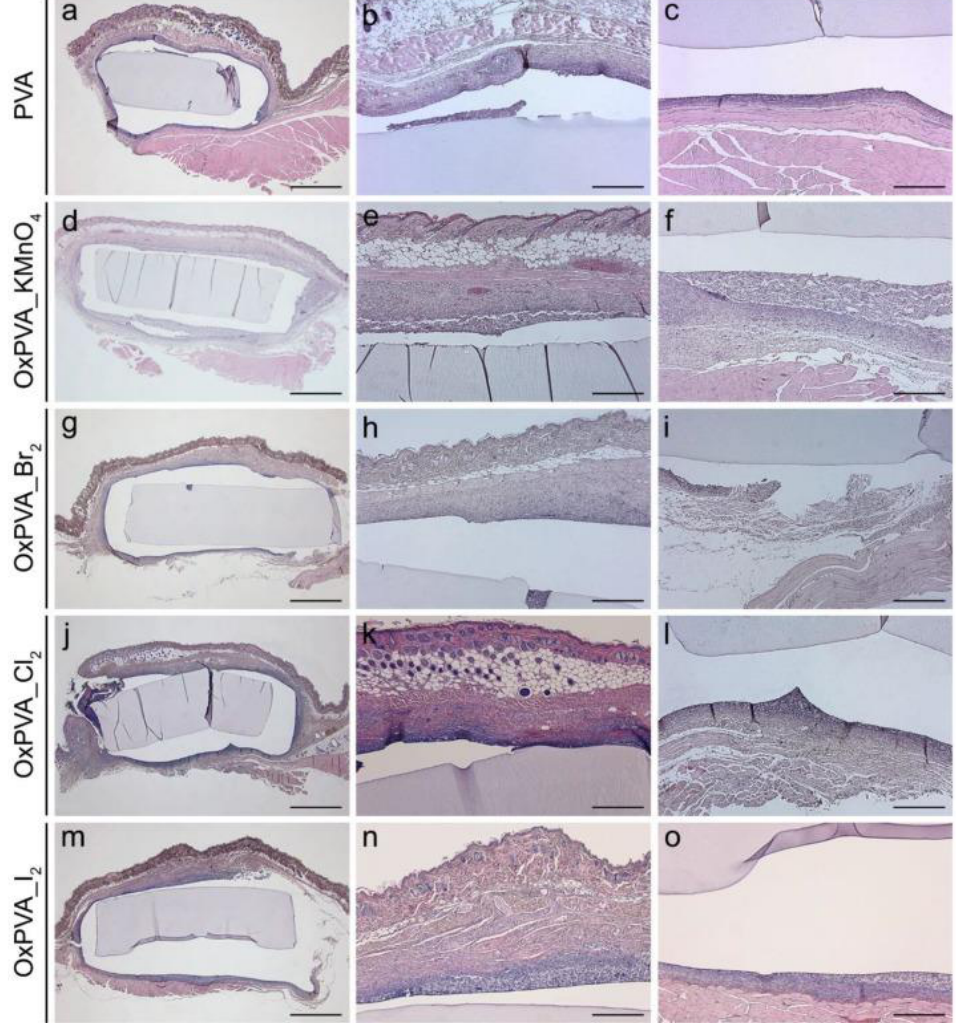
Figure 1. Histological evaluation of oxidized PVA scaffolds. Hematoxylin and eosin staining of neat and oxidized PVA scaffolds after four weeks of subcutaneous implantation into the dorsal region of BALB/c mice. ( a , d , g , j , m ) All hydrogel disks could be well identified among the surrounding tissues. ( b , e , h , k , n ) No severe inflammatory infiltration was observed at the subcutaneous and ( c , f , i , l , o ) muscular sides. Scale bars: ( a , d , g , j , m ) 100 µm; ( b , c , e , f , h , i , k , l , n , o ) 400 µm. OxPVA_KMnO 4 : PVA oxidized with potassium permanganate; OxPVA_Br 2 : PVA oxidized with bromine; OxPVA_Cl 2 : PVA oxidized with chlorine; OxPVA_I 2 : PVA oxidized with iodine. Reproduced with permission [17].